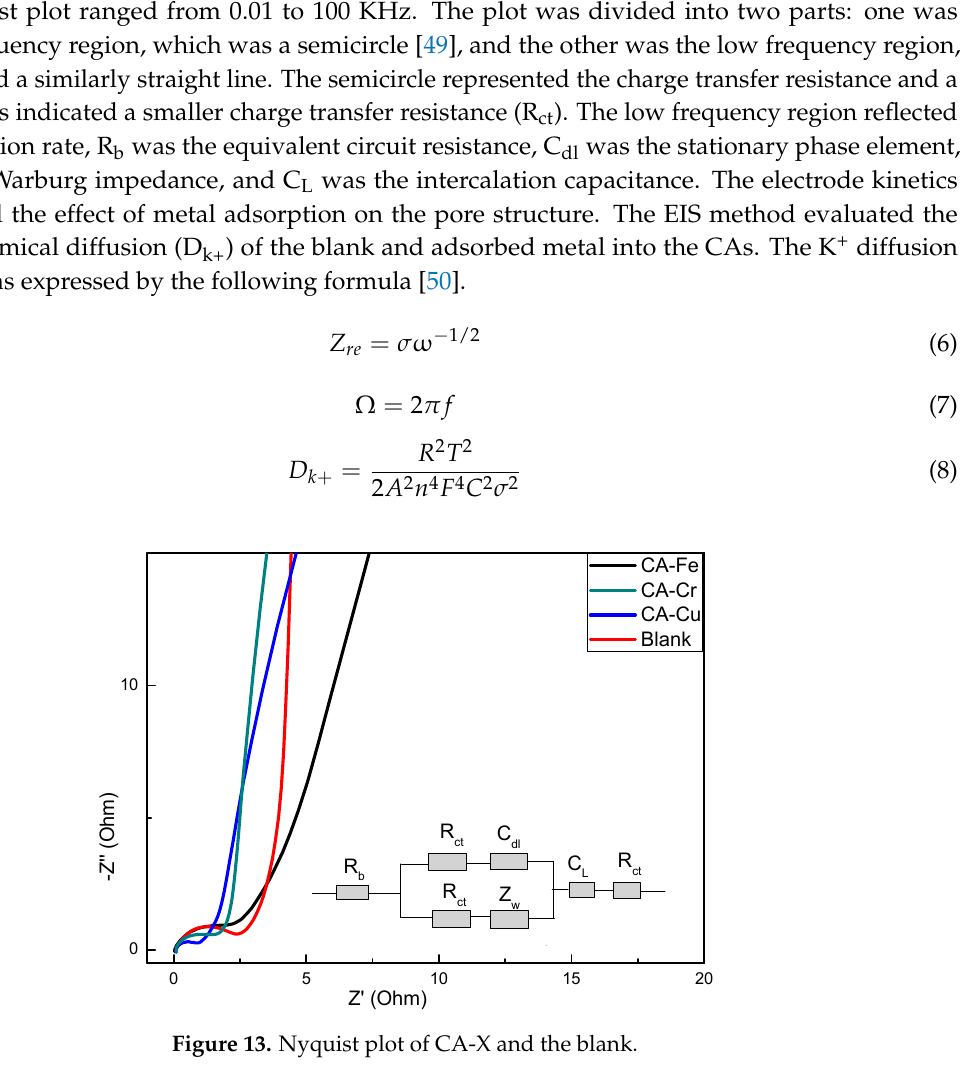
Figure 12. Charge/discharge cycles of CA-X, CA-Cu-0, and blank at the current density of 1.5 A·g − 1.